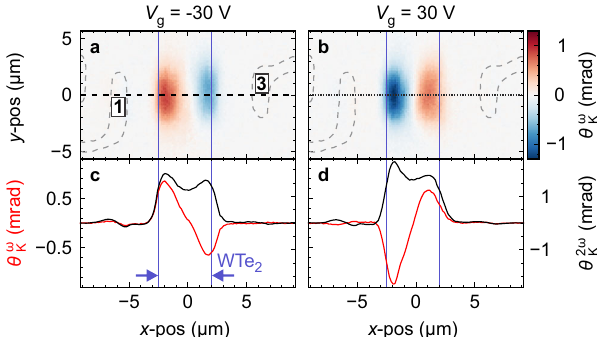
Fig. 3 Gate-dependent KR microscopy. Spatially-resolved KR, detected on the device in Fig. 1 under AC current injection along the graphene stripe ( V 13 = 4 V) for a V g = − 30 V and b V g = 30 V. Grey dashed lines highlight the metal electrodes, labelled 1 and 3. c , d Pro fi les of the current-induced Kerr angle θ ω K and the Joule heating-induced polarisation rotation θ 2 ω K , along the horizontal dotted/dashed lines in a and b . Vertical solid lines indicate the WTe 2 Fig. 2 Mapping of local charge current. Current-induced polarisation rotation θ 2 ω K (lower panel) for different bias con fi gurations of the graphene/ WTe 2 junction (upper panel). a , b Bias applied between graphene and WTe 2 . Bias applied along ( c ) WTe 2 and ( d ) graphene only. In c , the colour scale was expanded by a factor of eight for better visibility. The arrows indicate the direction of the ac current j as expected from the bias con fi guration. The numbers indicate the contacts used for biasing. All other contacts are fl oating. The scale bar is 2 μ m. Experimental parameters are V = 0 V, a V = 3 V, b V = 3 V, c V = 4 V, d V = 1.5 V. g 23 21 24 13 Figure 2 shows spatial maps of θ 2 ω around the WTe 2 /graphene K heterointerface, which were obtained in four different bias con- fi gurations. For source-drain bias applied vertically across the junction, the maximum signal is always located along the direc- tion of current fl ow, i.e., either to the right (contacts 2 and 3 are connected, Fig. 2a) or the left (contacts 2 and 1 are connected, Fig. 2b) towards the corresponding electrical contact on gra- phene. The signals scale approximately quadratically with the applied AC current amplitude, as expected for Joule heating (Supplementary Fig. S2). Thus, we conclude that the polarisation rotation demodulated at 2 ω indeed re fl ects the local dissipation